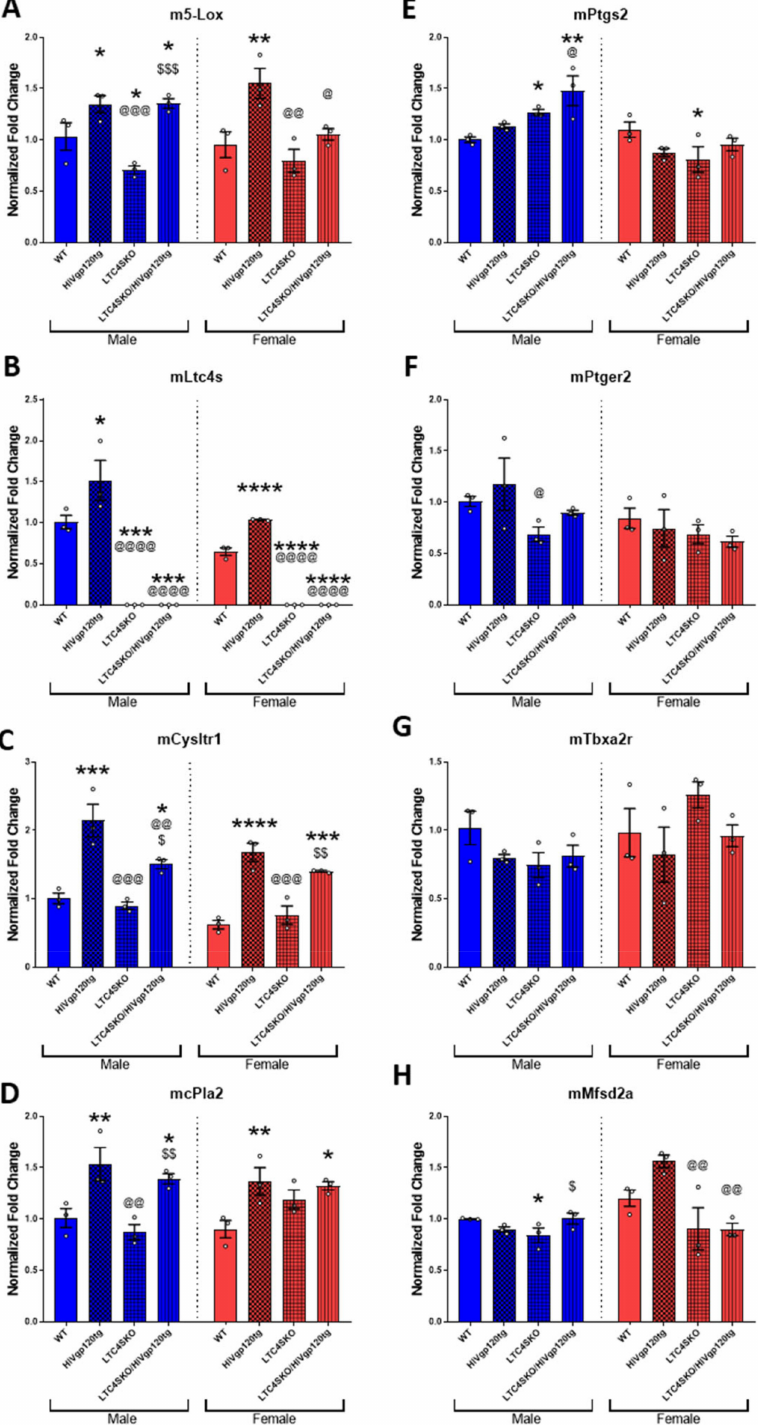
Figure 2. Gene expression levels quantified via qRT-PCR of eicosanoid pathway transcripts and lipid-associated proteins exhibit sexual dimorphism. LOX pathway-associated genes, m5-Lox ( A ), mLtc4s ( B ) and mCysLtr1 ( C ); eicosanoid cascade initiator, mcPla2 ( D ); COX pathway-associated genes, mPtgs2 ( E ), mPtger2 ( F ), and mTbxa2r ( G ); blood–brain barrier (BBB)